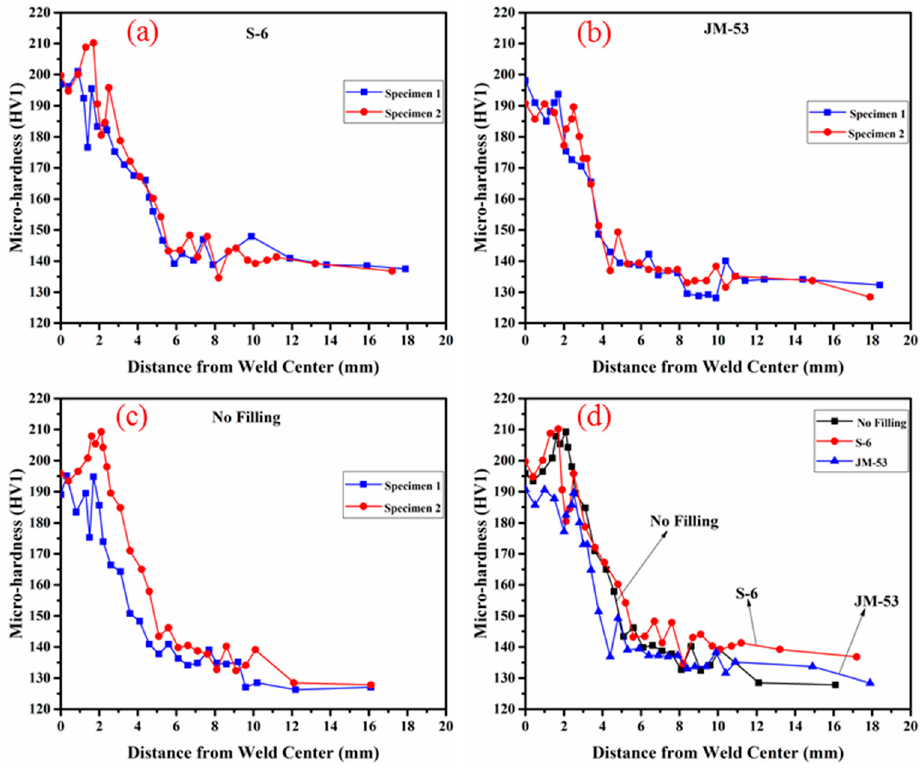
Figure 11. Micro-hardness distribution of welds using different welding wires ( a ) S-6; ( b ) JM-53; ( c ) No Filling; and ( d ) All.